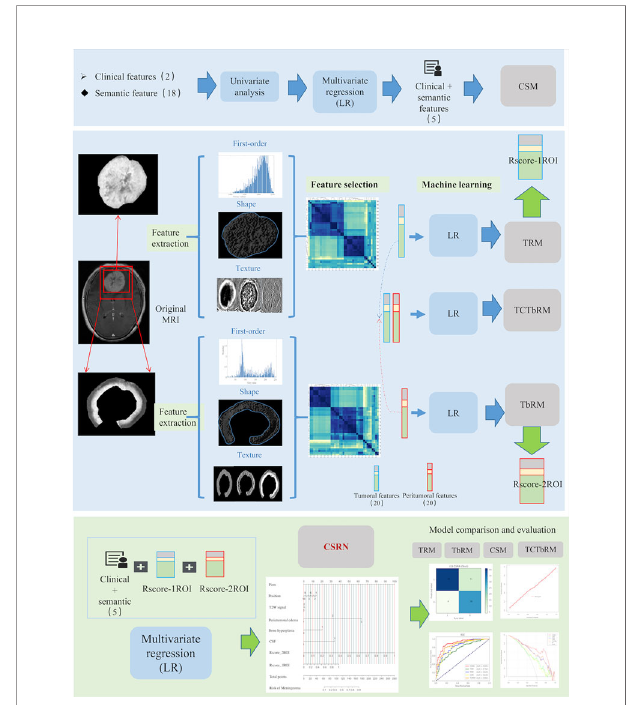
FIGURE 3 | Work fl ow of this study, which mainly composed of six steps: ROI segmentation, image preprocessing, feature extraction, feature selection, model building, and model comparative evaluation. ROI, region of